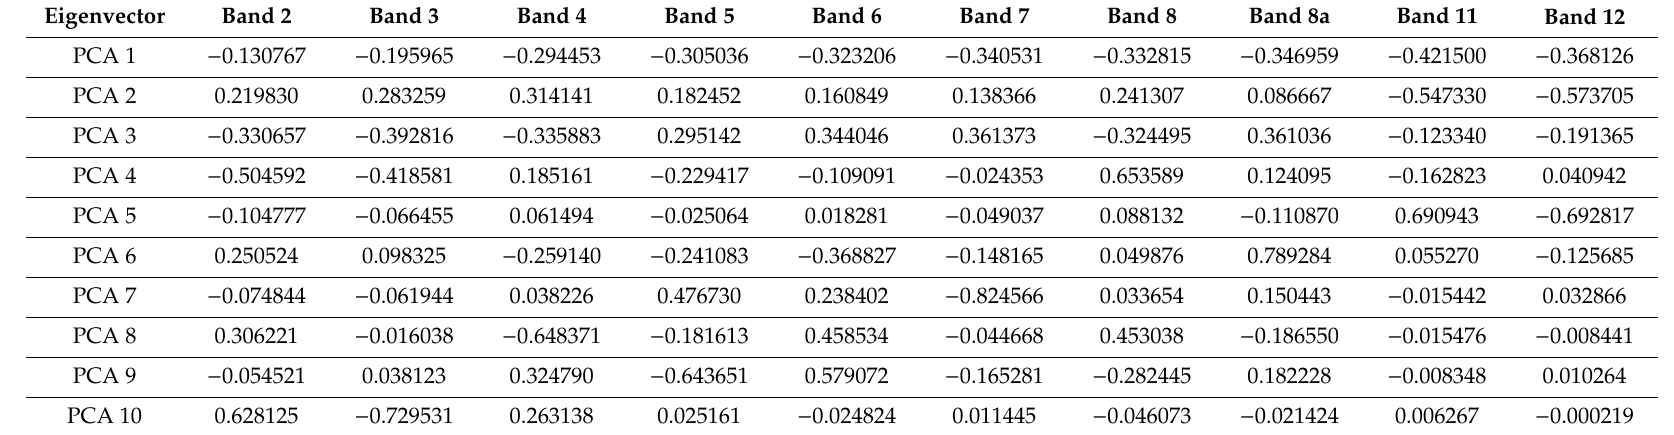
Table 4. Eigenvectors and eigenvalues of correlation matrix of Sentinel-2 PCA